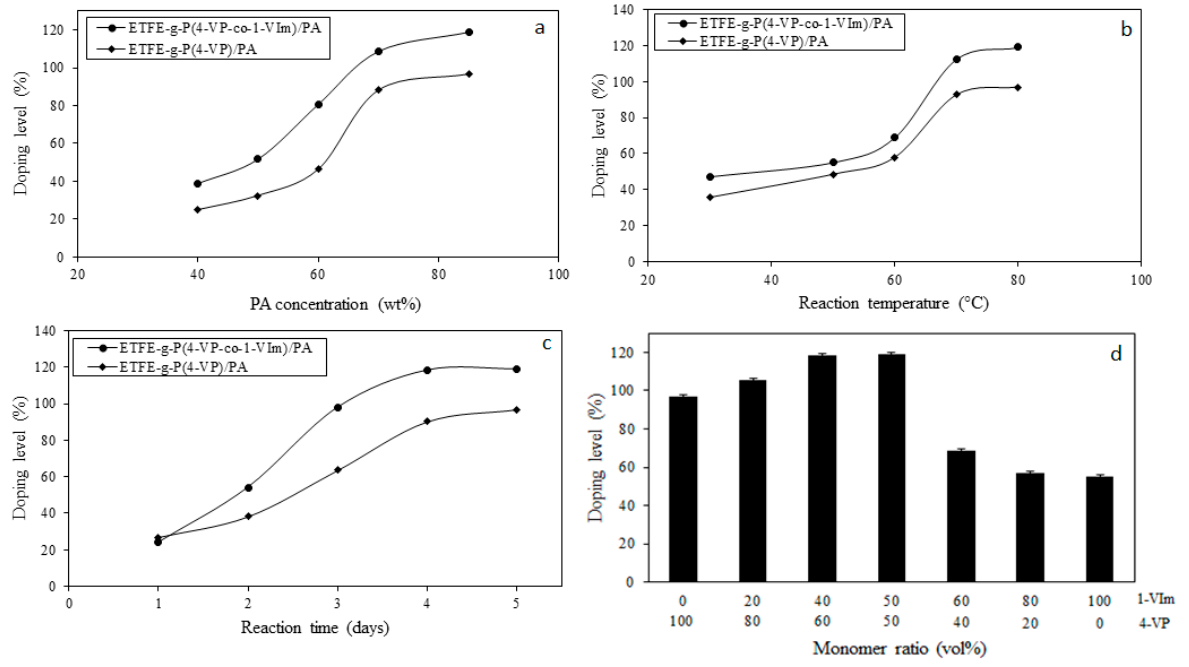
Figure 5. Variation of PA doping level for P(4-VP/1-VIm) grafted films with reaction parameters: ( a ) PA concentration, ( b ) reaction temperature, ( c ) reaction time, and ( d ) monomer ratio in grafting solution.